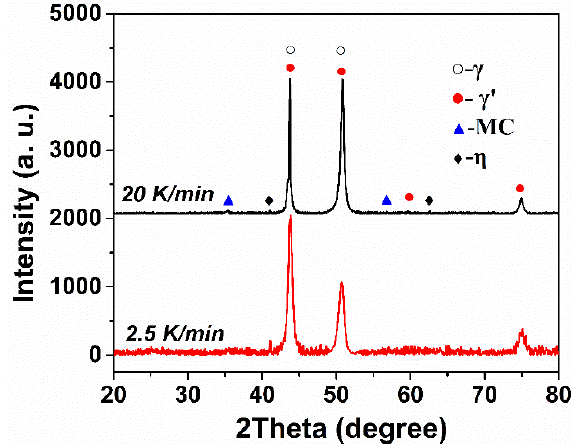
Figure 5. The XRD patterns of the GTD222 superalloy with a cooling rate of 2.5K/min and 20 K/min, respectively.